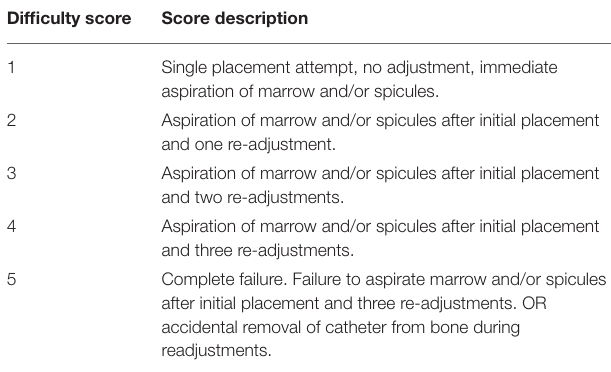
TABLE 2 | Intraosseous catheter placement difficulty